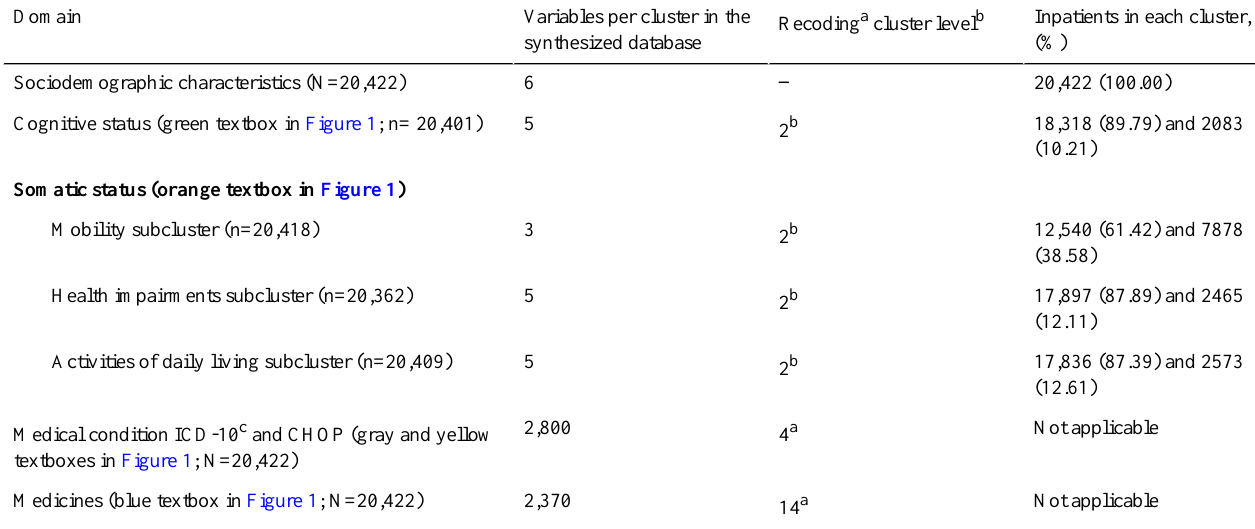
Table 7. Summary of the variables and clusters in the synthesized data set ready for further advanced statistical analysis.